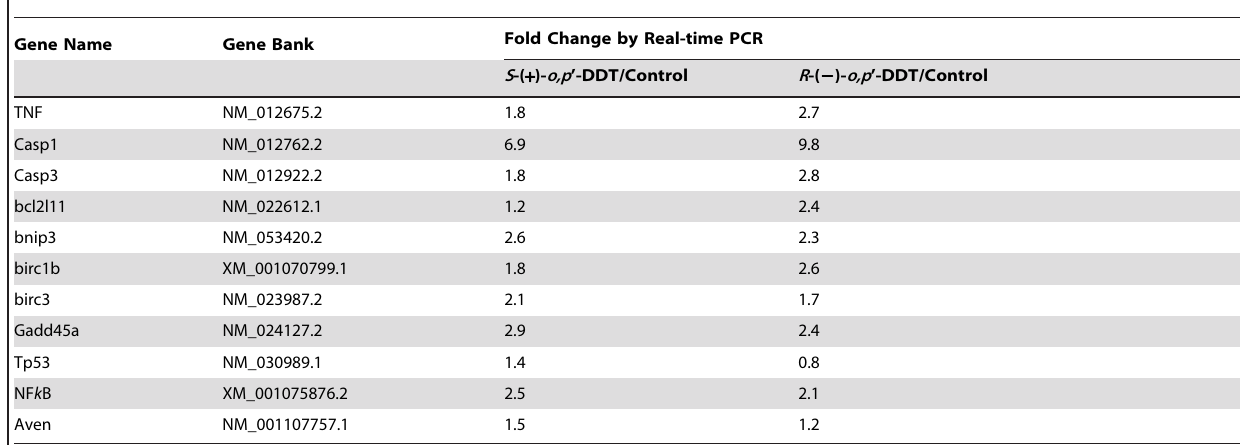
Table 2. Results of RT-PCR verification of microarray on enantiomers of o,p